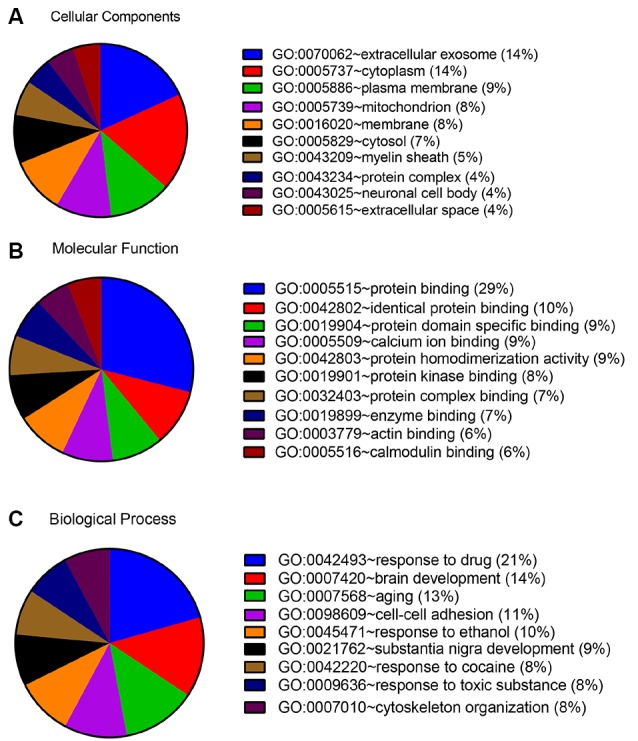
GO annotation analysis showed that acute ischemic stroke (IS) mainly involves exosome components and binding response to drug. (A) GO annotation by DAVID summarizing cellular components. (B) GO annotation summarizing molecular function. (C) GO annotation summary according to biological process.